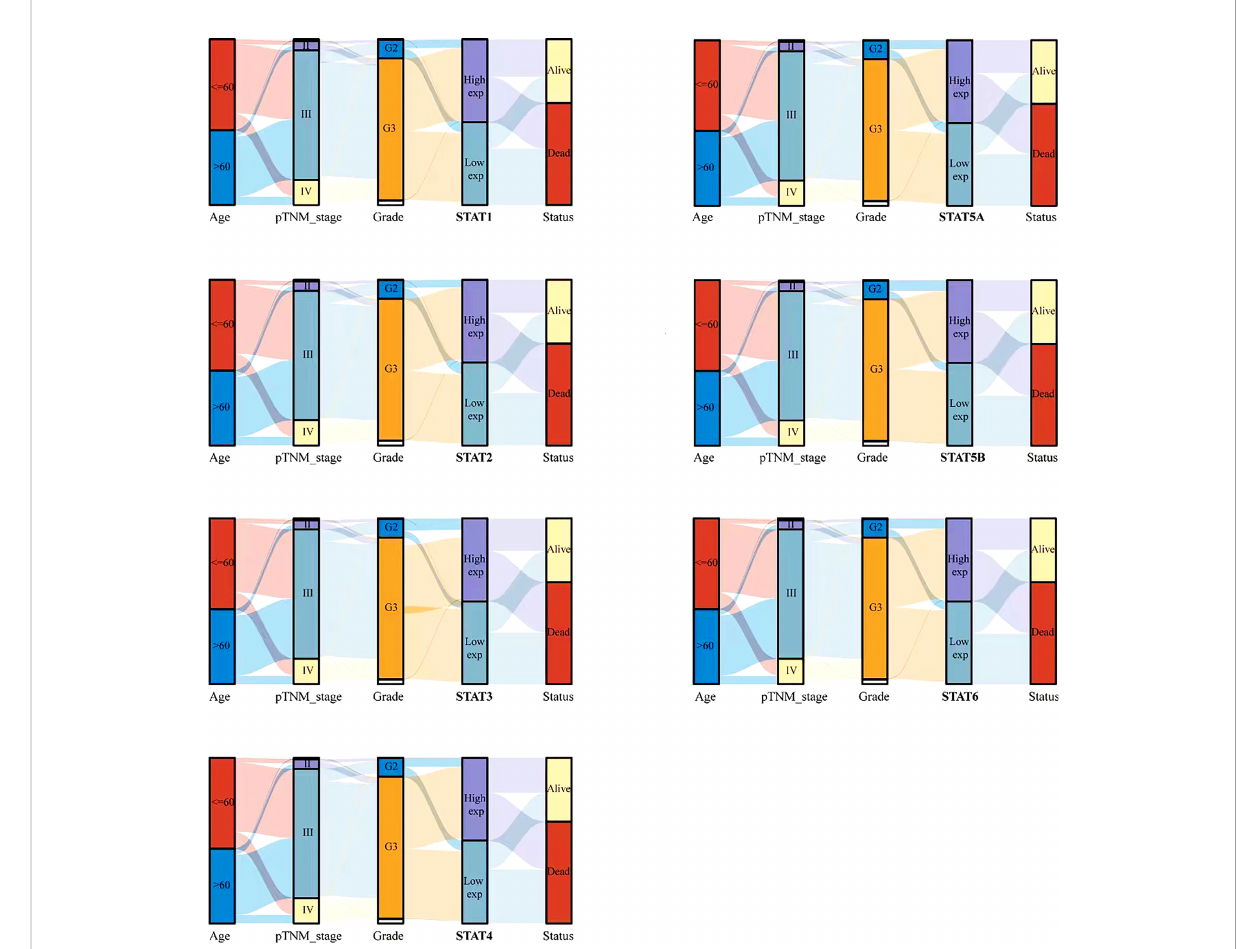
FIGURE 4 Relationship between STAT family and clinical characteristics of ovarian cancer patients. Rows represent feature variables, different color represents different age (<=60 years, >60 years) or pTNM_stage (I, II, III, IV) or Grade (G1, G2, G3) or expression level (High exp, Low exp) or survival status (Alive, Dead). Lines show how the same sample is distributed across different feature variables.